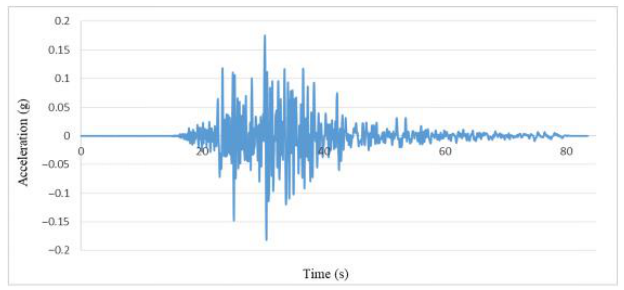
Figure 17. South-North acceleration-time curve of the 2011 Van earthquake. The time-displacement curves of the sample minaret for the 2011 Van earthquake were given in Figures 18–20 for adobe, Süphan Basalt, and C25 concrete, respectively.